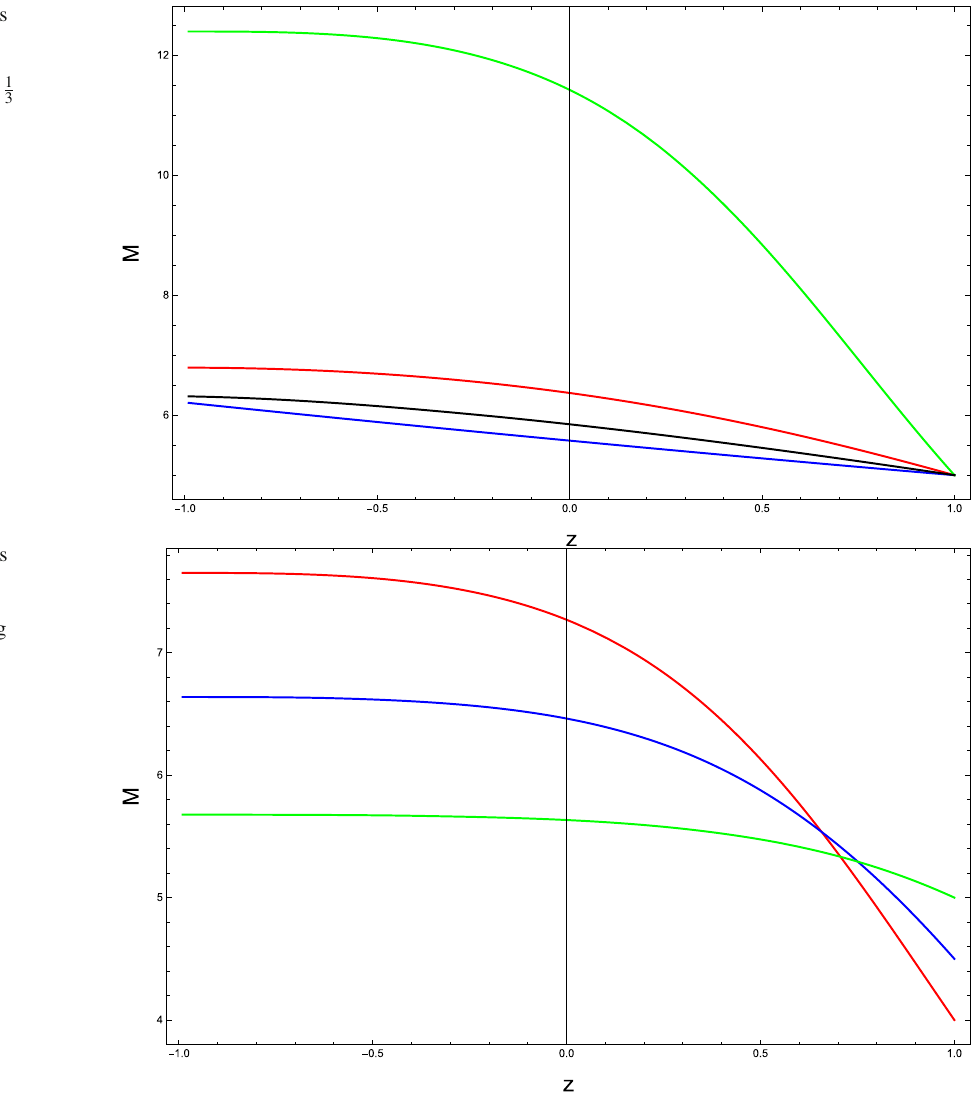
Fig. 8 Evolution of PBH mass M ( z ) with redshift z for different ω in case of an Emergent Universe. Here ω = 1 3 (red), ω = − 1 (blue), ω = 1 3 (green) and ω = 0 (black)